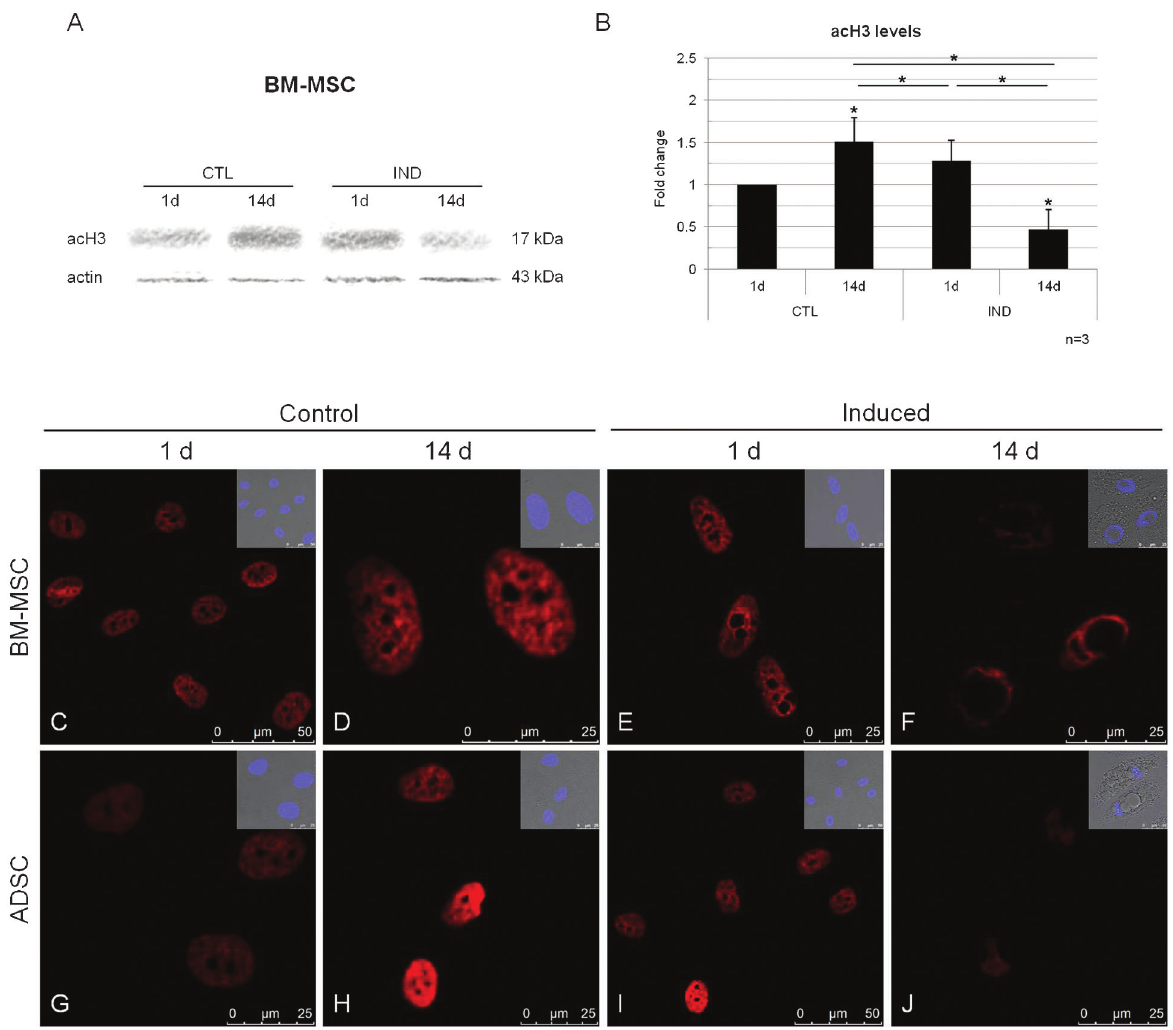
Figure 1. Analysis of histone acetylation during the differentiation of MSCs into adipocytes. A , Western blot showing changes in acH3 levels after 1 and 14 days of control culture conditions (CTL) or adipocyte differentiation induction (IND); an actin probe was used as a loading control. B , Quantitative analyses of relative acH3 levels. Data are reported as means ± SD. MSCs = mesenchymal stem cells; BM-MSCs = bone marrow MSCs; ADSCs = adipose tissue stem cells; d = day. Asterisks just above SD bars show the statistical significance of the difference with respect to control cultures after 1 day. *P , 0.05 (Student t -test). C-J , Immunofluorescence images of BM-MSCs ( C-F ) and ADSCs ( G-J ), showing acH3 staining (red) after 1 and 14 days of induction or non-induction. Minor boxes show merged images of differential interference contrast and nuclei counterstained with